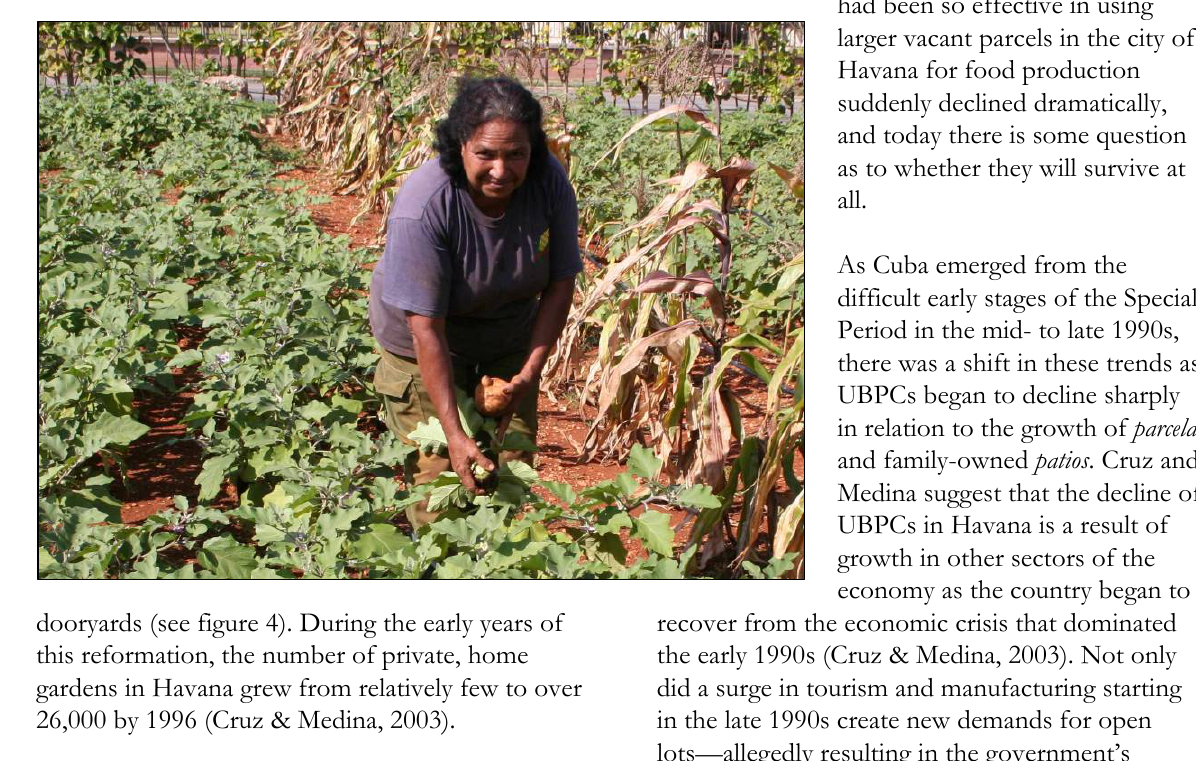
Figure 4. Gardener in her patio garden in Havana’s Versalles